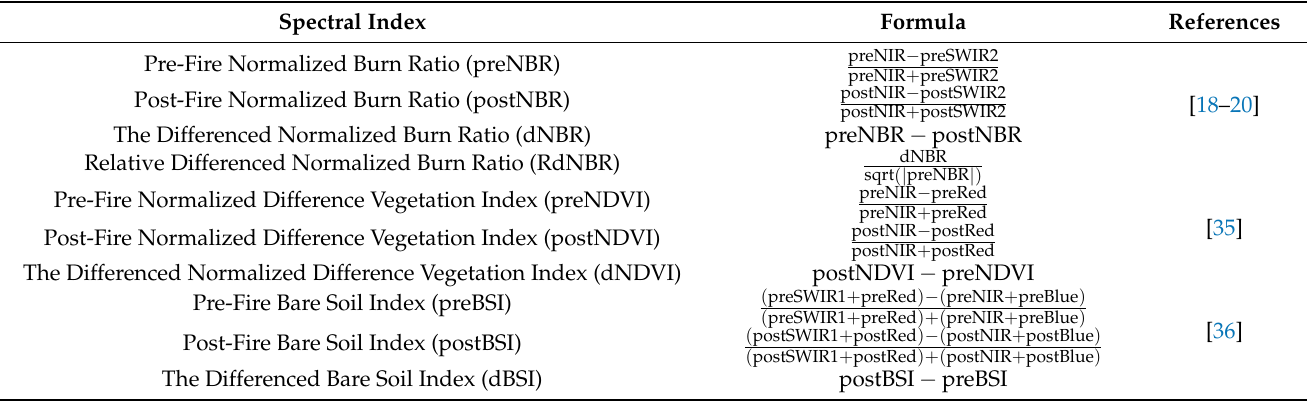
Table 6. Spectral indexes calculated from Sentinel 2